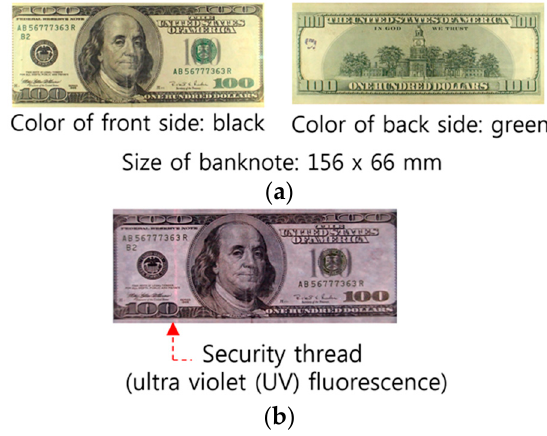
Figure 10. Visible light reflection image and ultraviolet fluorescence factor on a USD 100 bill: ( a ) The visible light reflection image of the recent USD $100; ( b ) Anti-counterfeiting feature.